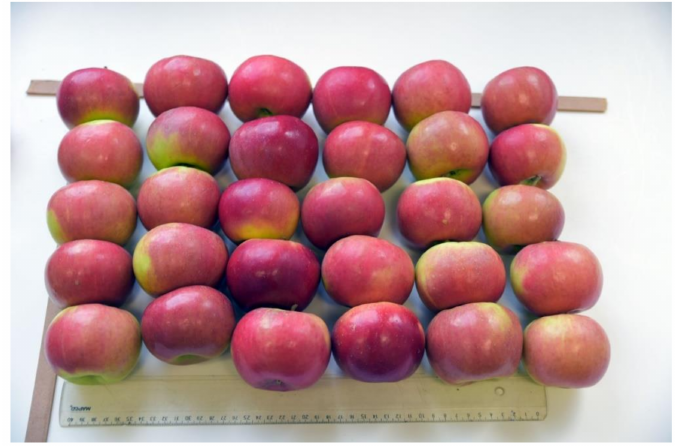
Figure 1. ‘Topaz’ apples at harvest subject to three treatments: N1 = 1.4 kg N ha − 1 (left 10), N0 = sprayed with water only (middle 10), N4 = 4 kg N ha − 1 (right 10).